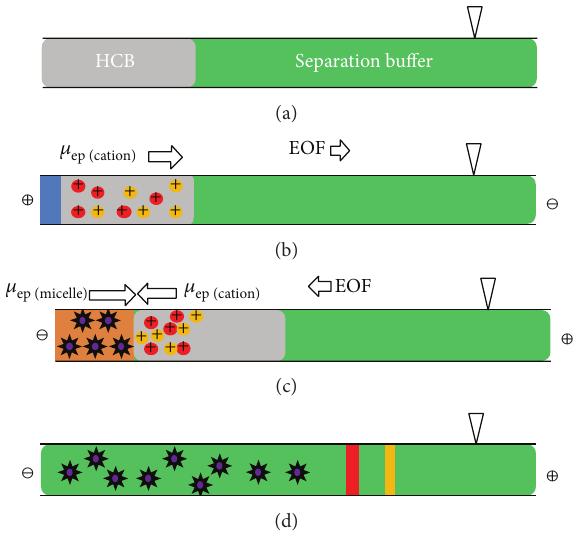
Figure 1: The mechanism of CSEI-sweeping-MEKC mode (adapted from [13]). (a) The capillary was rinsed with a nonmicellar, low-pH separationbuffer.HCBzonewasthenintroducedhydrodynamically. (b) Cationic samples prepared in low conductive matrix were injected into capillary by positive voltage and concentrated in the HCB zone. (c) The concentrated cationic samples in HCB zone were then swept into a narrow zone by anionic micelles from the inlet sweeping buffer. (d) MEKC separation.